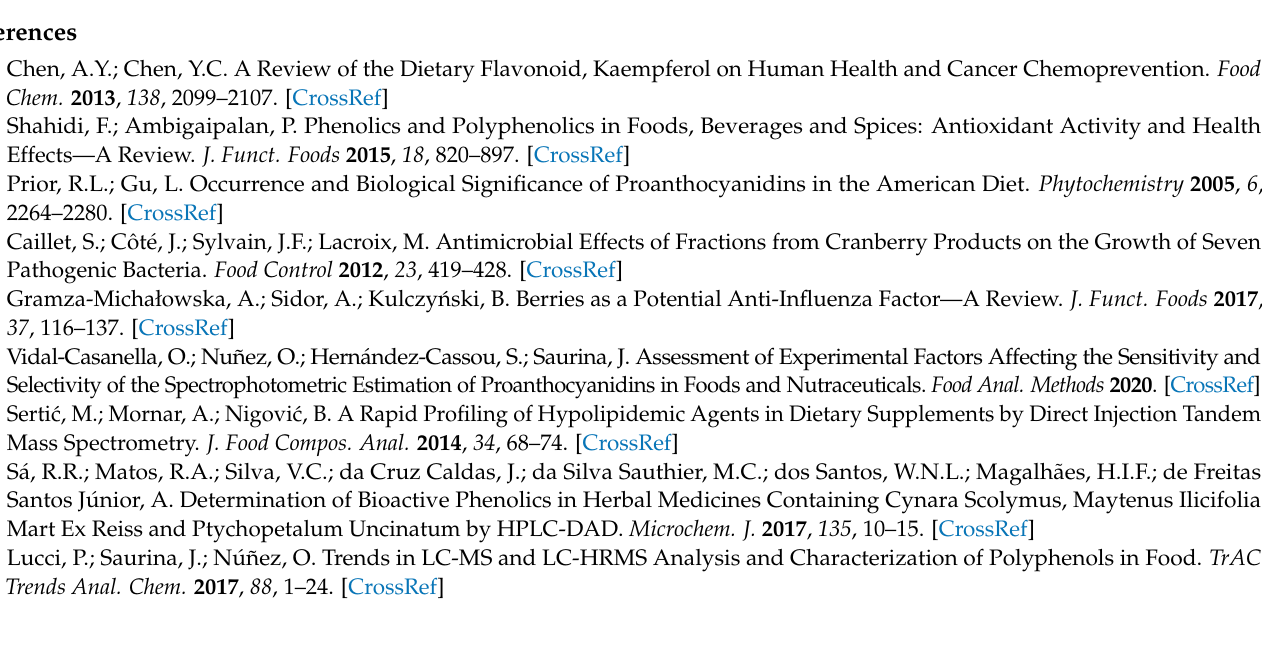
Figure S4. Scatter plot of scores of PC1 vs. PC2 vs. PC3 for the characterization of nutraceuticals and dietary supplements by PCA using the chromatographic fingerprints in the time range 3.5 to 25.5 min as the data. Sample assignation: see Figure S2. Figure S5. Characterization of nutraceuticals and dietary supplements by PLS-DA using the chromatographic fingerprints in the time range 6.2–12 min as the data. (a) Estimation of the number of latent variables by Venetian blinds cross validation (arrow indicates the selected number of LVs which provides the minimum prediction error); (b) scatter plot of scores of PC1 vs. PC2. Sample assignation: see Figure S2. Table S1. Peak features of